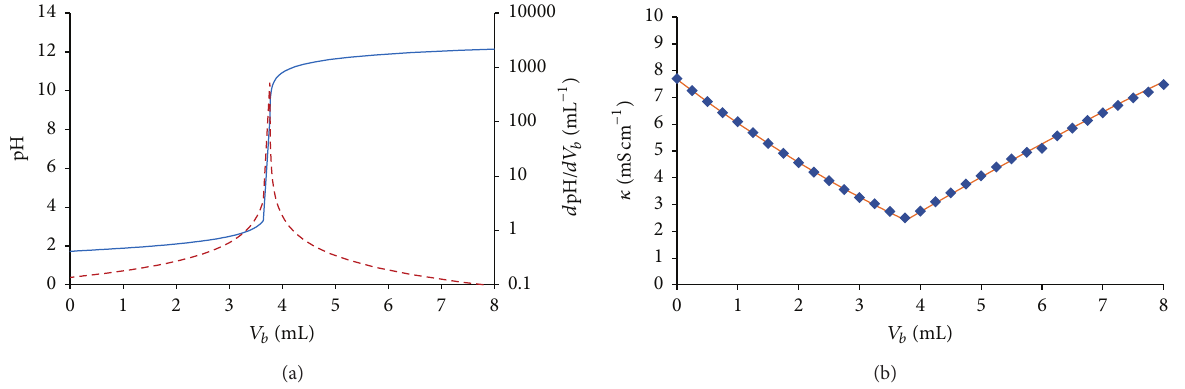
Figure 2: Plots obtained during titration of 20.00 mL H 2 SO 4 0.024 M + 20.0 mL deionized water with NaOH 0.2550 M, at 25 ∘ C. (a) pH-metric plots: the solid line represents the plot pH = 𝑓(𝑉 𝑏 ) obtained with (10) while the segmented line represents the plot of 𝑑 pH /𝑑𝑉 𝑏 = 𝑓 󸀠 (𝑉 𝑏 ) ≈ 𝜅 = 𝑔(𝑉 ) . The markers represent the experimental points obtained and the solid line represents the Δ pH /Δ𝑉 𝑏 . (b) Conductometric plot 𝑏 estimated plot with